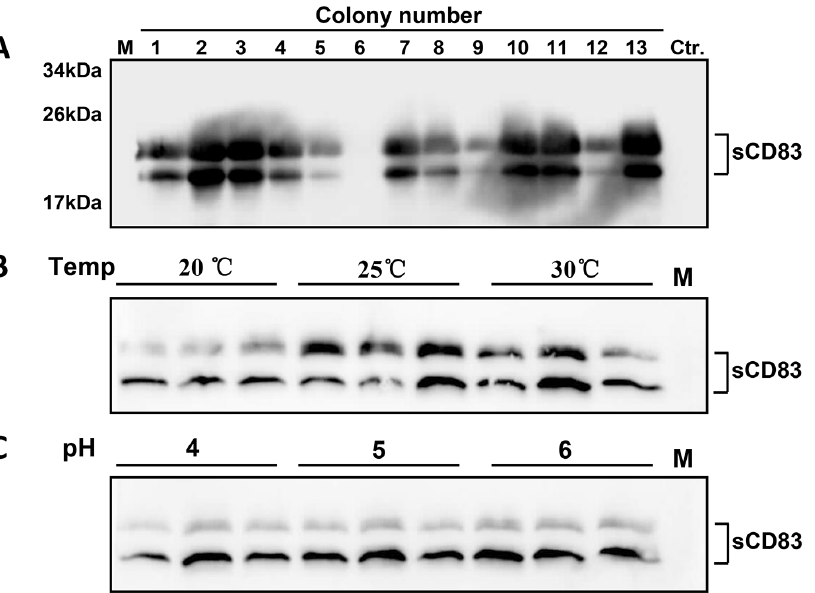
Figure 2. The screening and optimization of sCD83 expression in flasks. (A) The screening of high-expressing colonies of sCD83 from YPDG plates. 1–13: the colony number, Ctr. : the GS115/pPIC9K control. (B) The optimization of the induction temperature in flasks. (C) The optimization of the induction pH in flasks. Each experiment with these conditions was performed in triplicate.